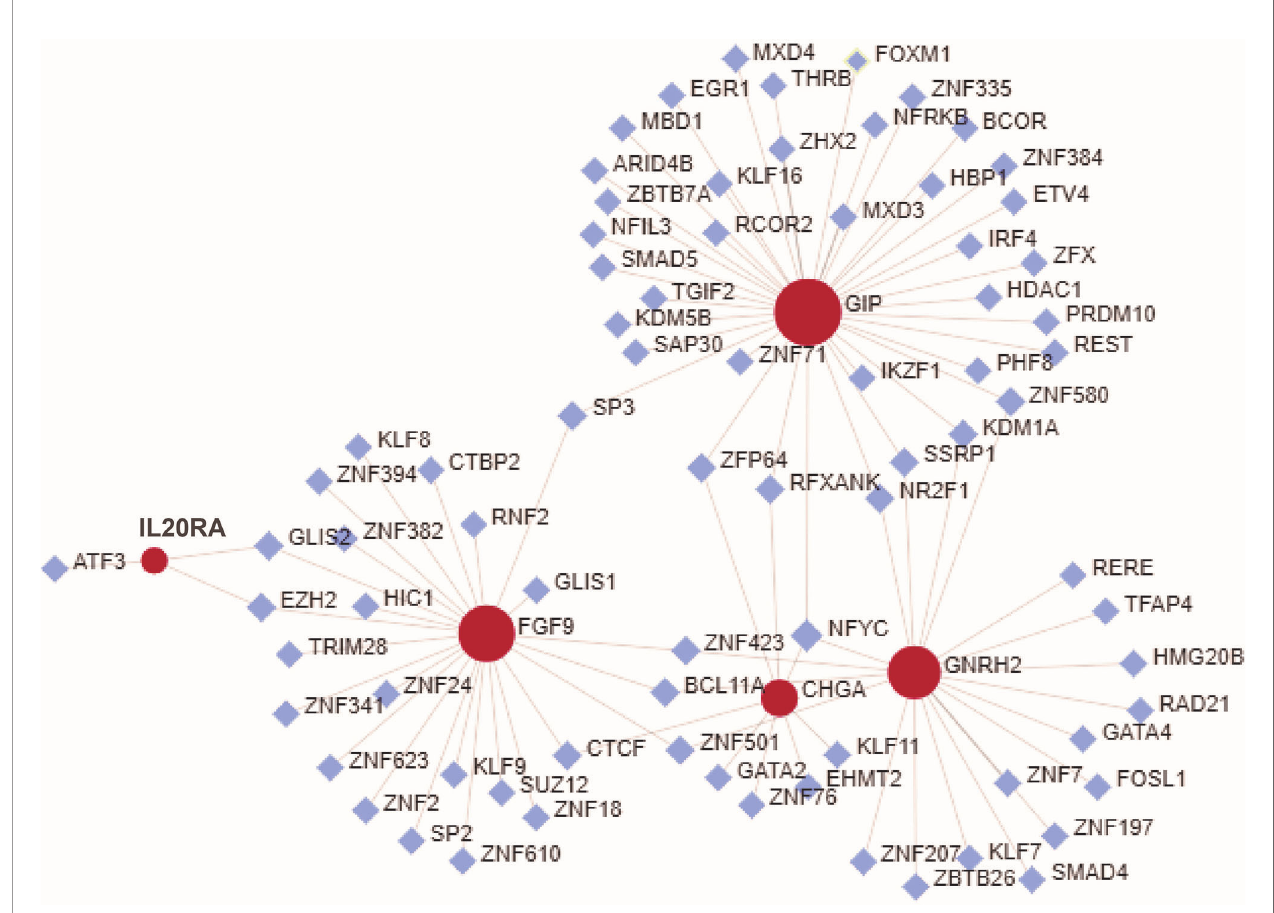
FIGURE 7 | Mechanisms of the immune ‐ related risk signature. Transcription factors ‐ based regulatory network with the eight immune ‐ related genes in the